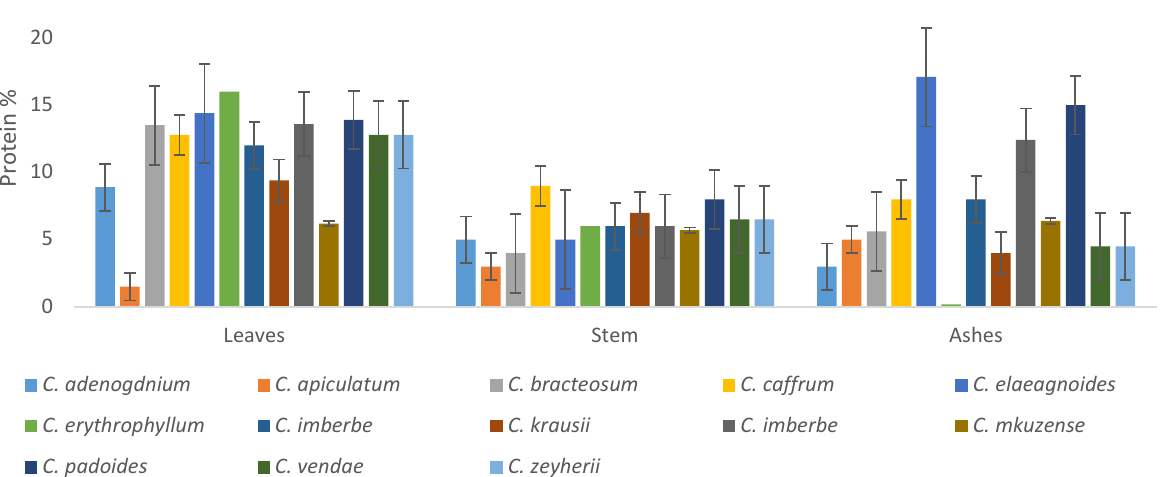
Figure 9. Protein percentage of the leaves, stems, and ashes of the Combretum species. All the plants had appreciable amounts of energy, with C. adenogdnium exhibiting the highest concentrations for both leaves and stems, as illustrated in Figure 10. The ashes C. erythrophyllum had the lowest energy overall.